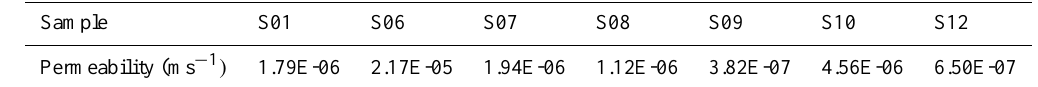
Table 1. Permeability values for granular soil samples computed according to Alyamani et al. (1993).